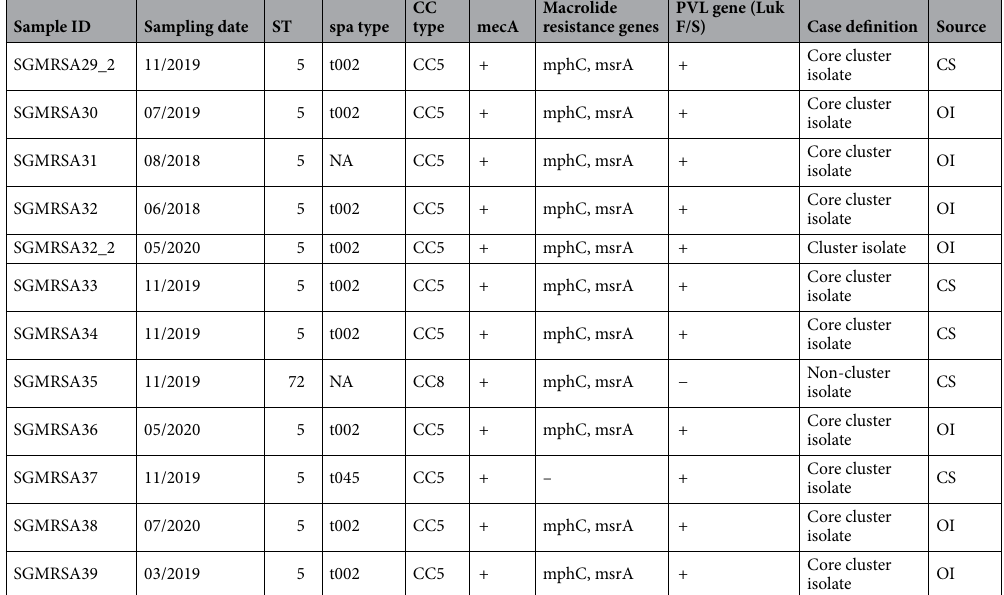
Table 2. Results of whole-genome sequencing of CA-MRSA isolates (N = 46). + presence of mecA, LukS/F; − absence of mecA, LukS/F; ST (Sequence Type) according to S. aureus multi-locus sequence typing (MLST); spa type ( S. aureus -specific staphylococcal protein A) ; CC type (clonal complex); PVL (Panton-Valentine Leukocidin); NA (not available). Extension _2 means duplicate or follow-up isolate (depending on the date of isolation) of a given